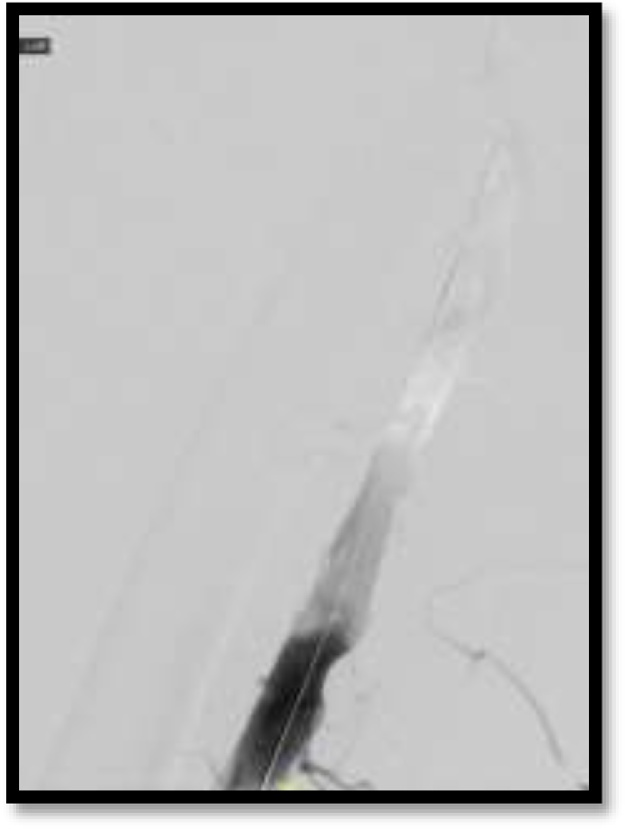
Venogram Pre PCDT.